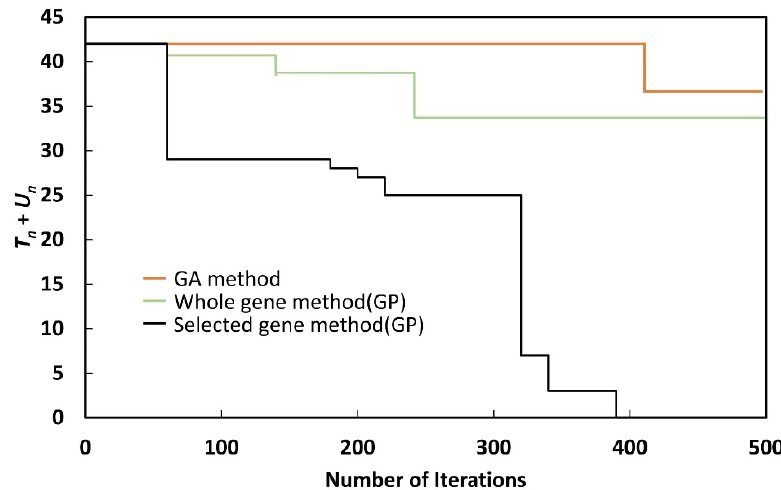
Figure 12. GP results for the minimized fitness function (2021).